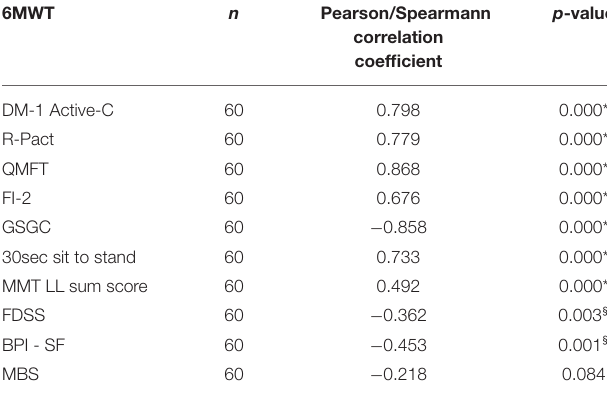
TABLE 4 | 6MWT convergent validity: correlations with other motor function outcome measures and patients reported